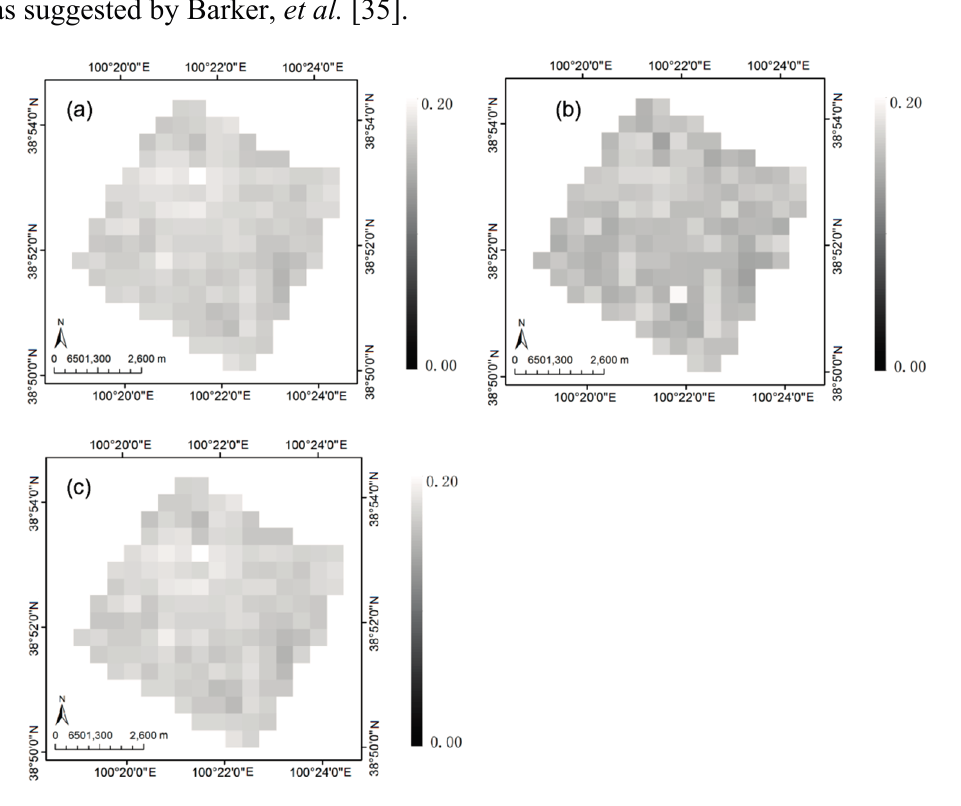
 denoted by CASI agg_cor i